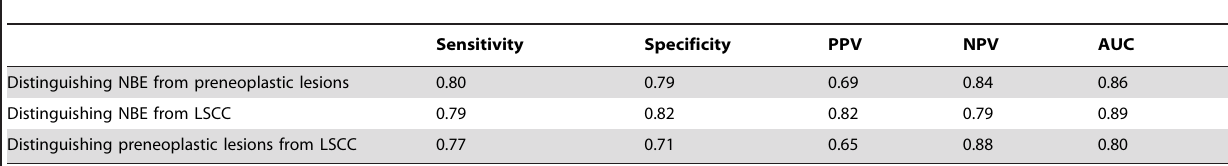
Table 2. Receiver operating characteristics from IHC scores of SELENBP1 in distinguishing NBE from preneoplastic lesions from invasive LSCC.